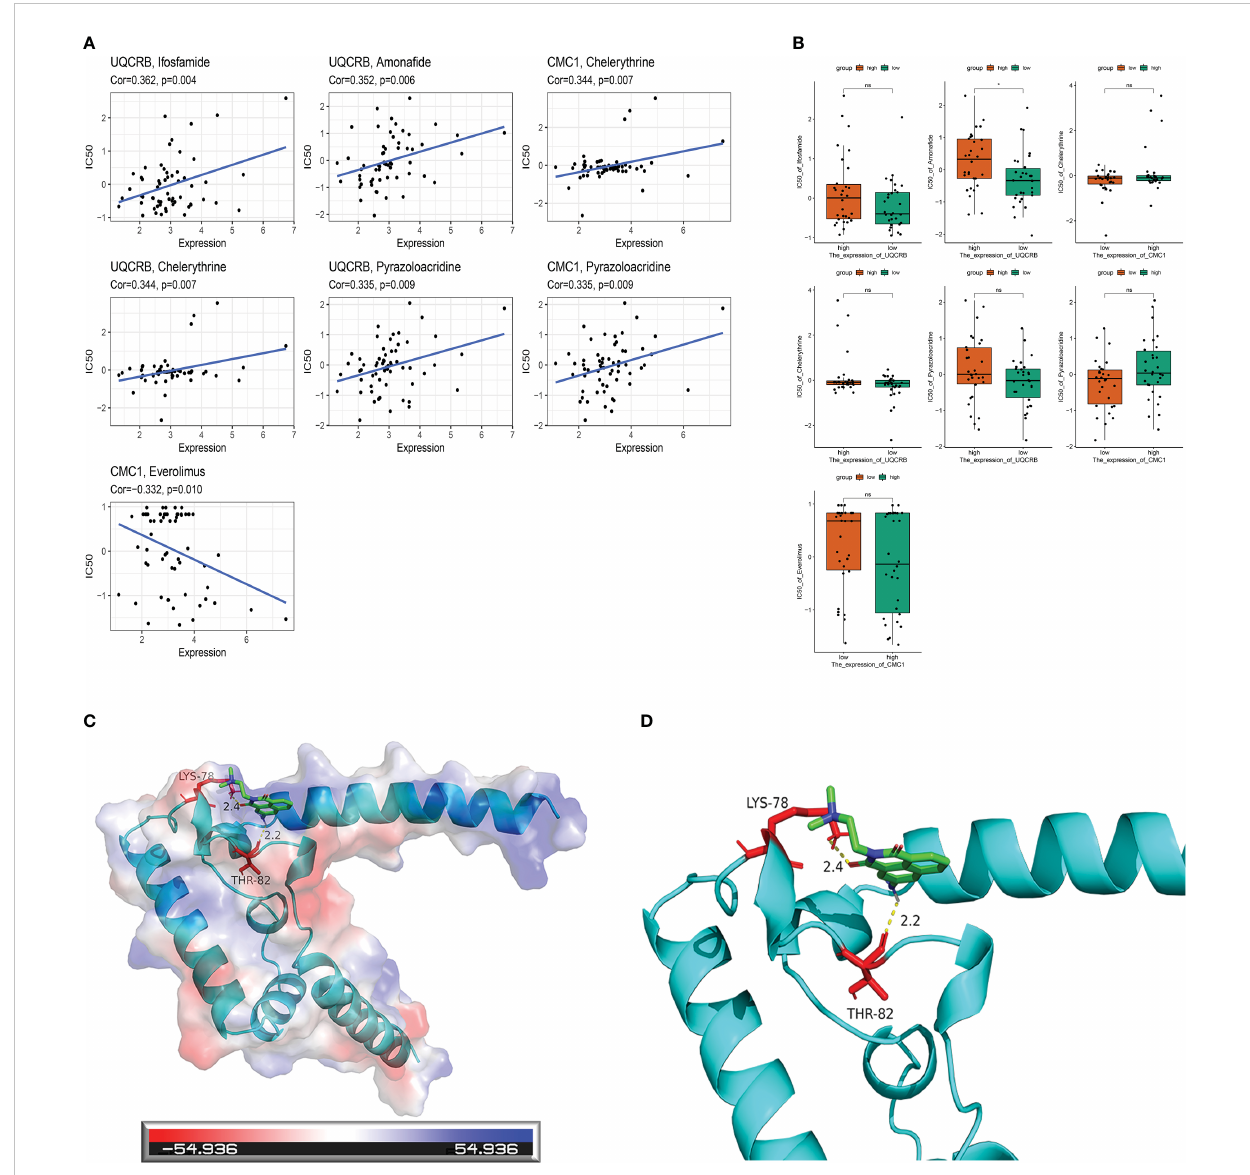
FIGURE 9 Mitochondria-related prognostic genes and drug sensitivity analysis with molecular docking. (A) Correlation analysis of UQCRB, CMC1 corresponding to drug sensitivity in the CellMiner database; (B) Correlation analysis of UQCRB, CMC1 expression and corresponding drug sensitivity in the CellMiner database (C) UQCRB and Amona fi de molecular docking in general; (D) UQCRB and Amona fi de molecular docking local ampli fi cation